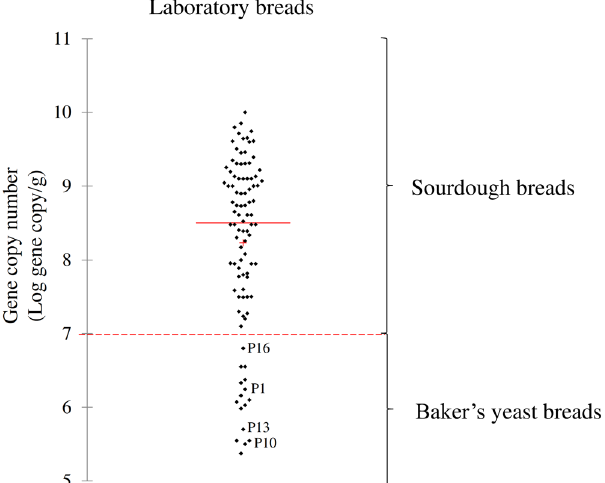
Figure 1. Scatterplot based on gene copy number as determined from laboratory breads. Scatterplot based on gene copy numbers of traditional and dried sourdough or baker’s yeast breads made under pilot scale/laboratory conditions. Mean ( + ), median (red line), and cut-off (dashed line) values are shown. Dried sourdough breads coded as P1, P10, P13, and P16 were made using 2.2% [wt/wt] of dried sourdough. The ingredients and technology parameters used for bread made at the pilot plant scale (laboratory) are reported in Table 2.